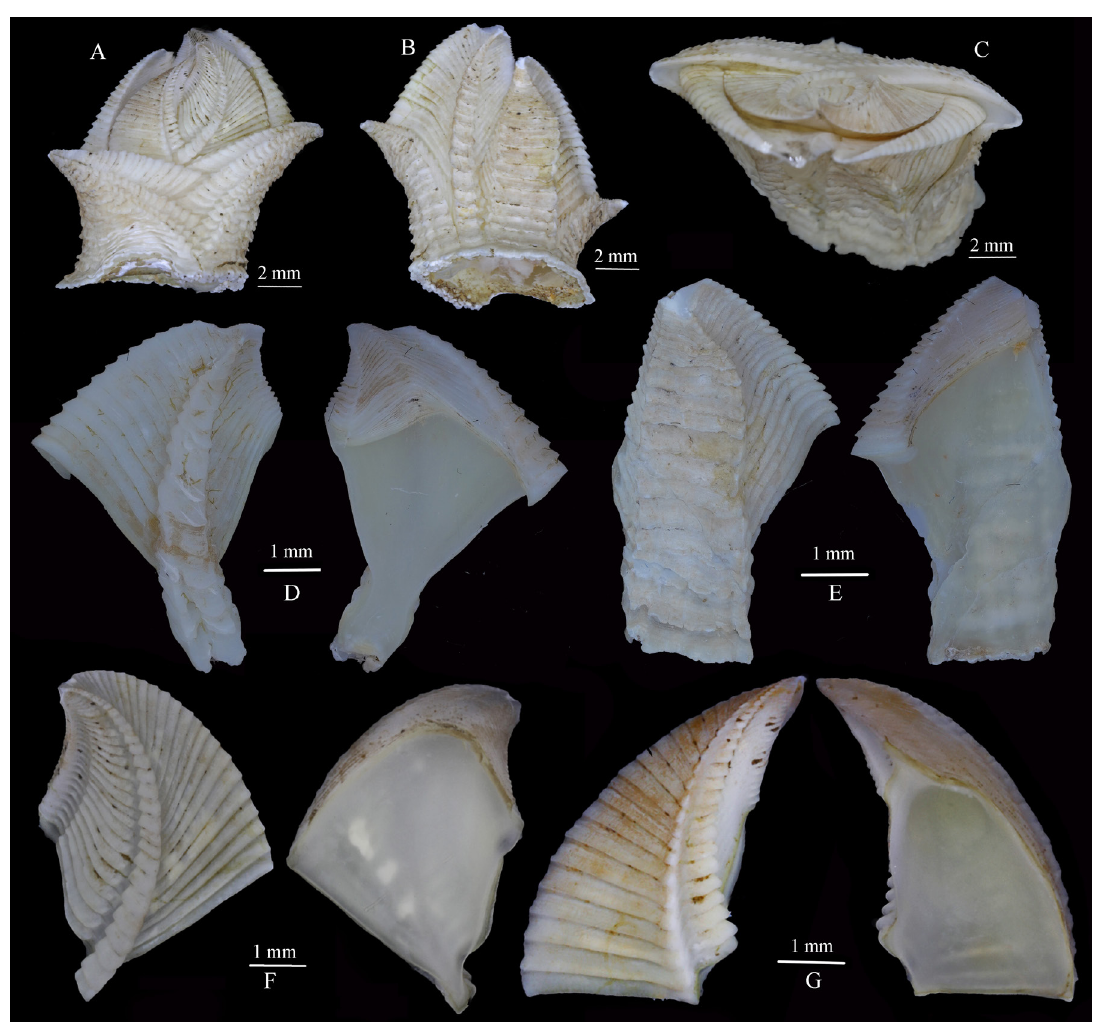
Fig. 1. Gibbosaverruca weijiai sp. nov., holotype, SRSIO17090313. A . Opercular plates. B . Fixed tergum and scutum. C . From above. D . Fixed tergum. E . Fixed scutum. F . Movable tergum. G . Movable